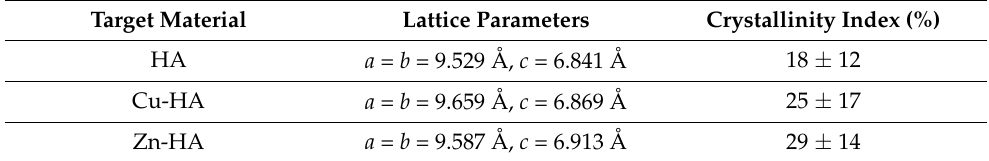
Table 4. Lattice parameters and crystallinity index of CaP coatings deposited from different tar- gets.